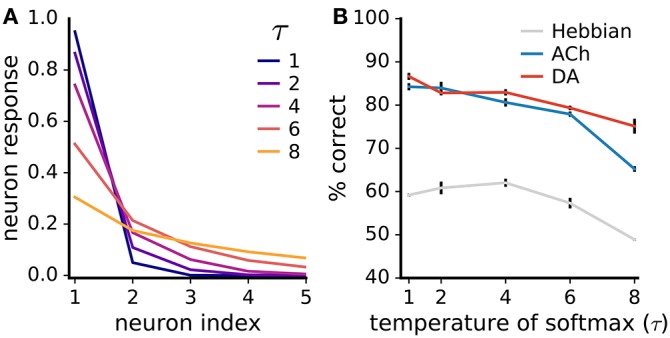
Neuromodulator-based learning improves performance also for low code sparseness. (A) Impact of the temperature parameter τ of the softmax function (Equation 14) on the sparseness of the neural code. The neuron indices are ordered from highest to lowest neural responses; the five most active neurons are shown. (B) Rate of correct classification for different τ values. Performance is on the non-uniform MNIST dataset. Data are mean of 3 runs, error bars are the standard deviation. Although performances drop with weaker competition, neuromodulators boost accuracy even for low code sparseness.